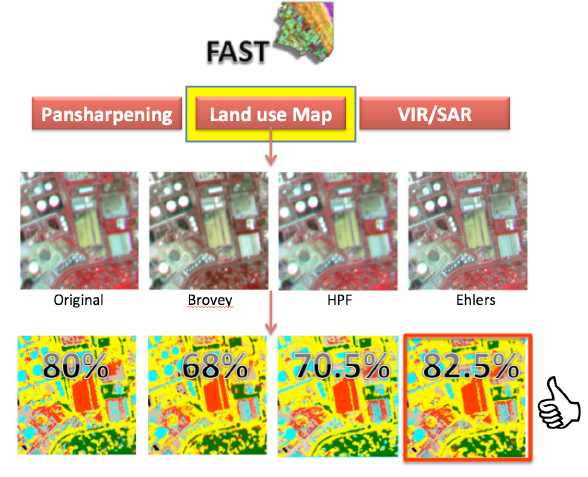
Figure 2. Concept of